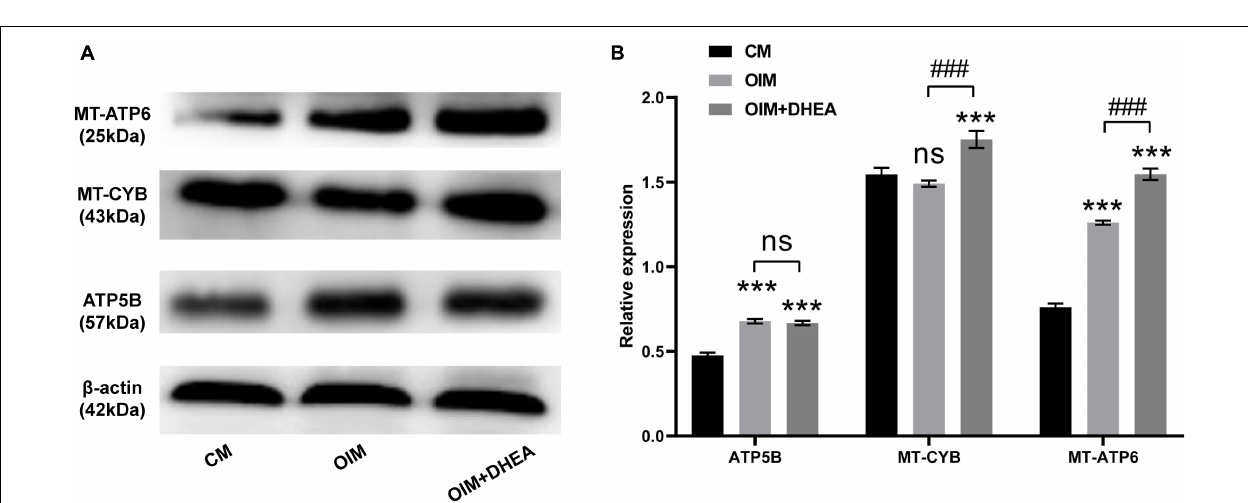
FIGURE 6 | Protein-protein interaction network for the proteins in the metabolic pathways of OIM vs. CM group (A) and OIM+DHEA vs. CM group (B) .